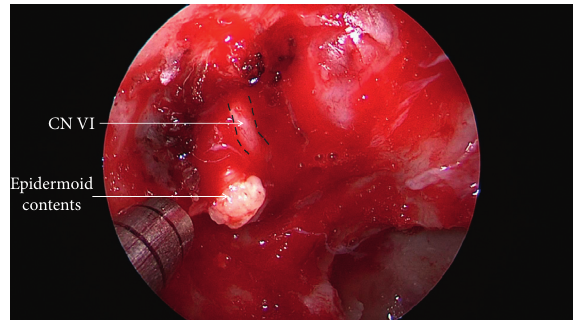
Figure 7: Visualization of the typical epidermoid contents fol- lowing capsular opening inferolateral to the abducens nerve.